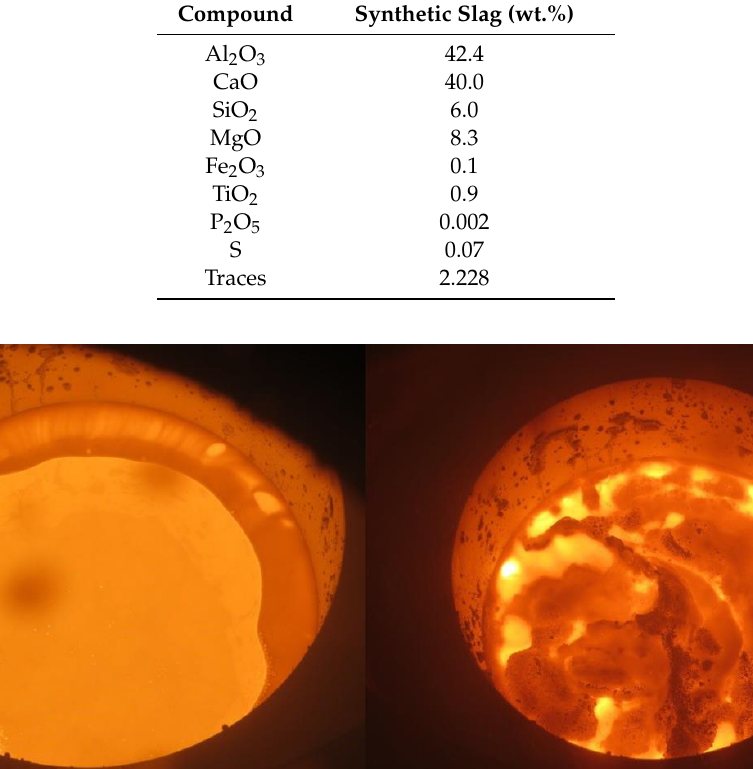
Figure 2. Formation of slag layer on top of molten steel in the crucible inside the metal casting simulator (exemplary without sample equipment).